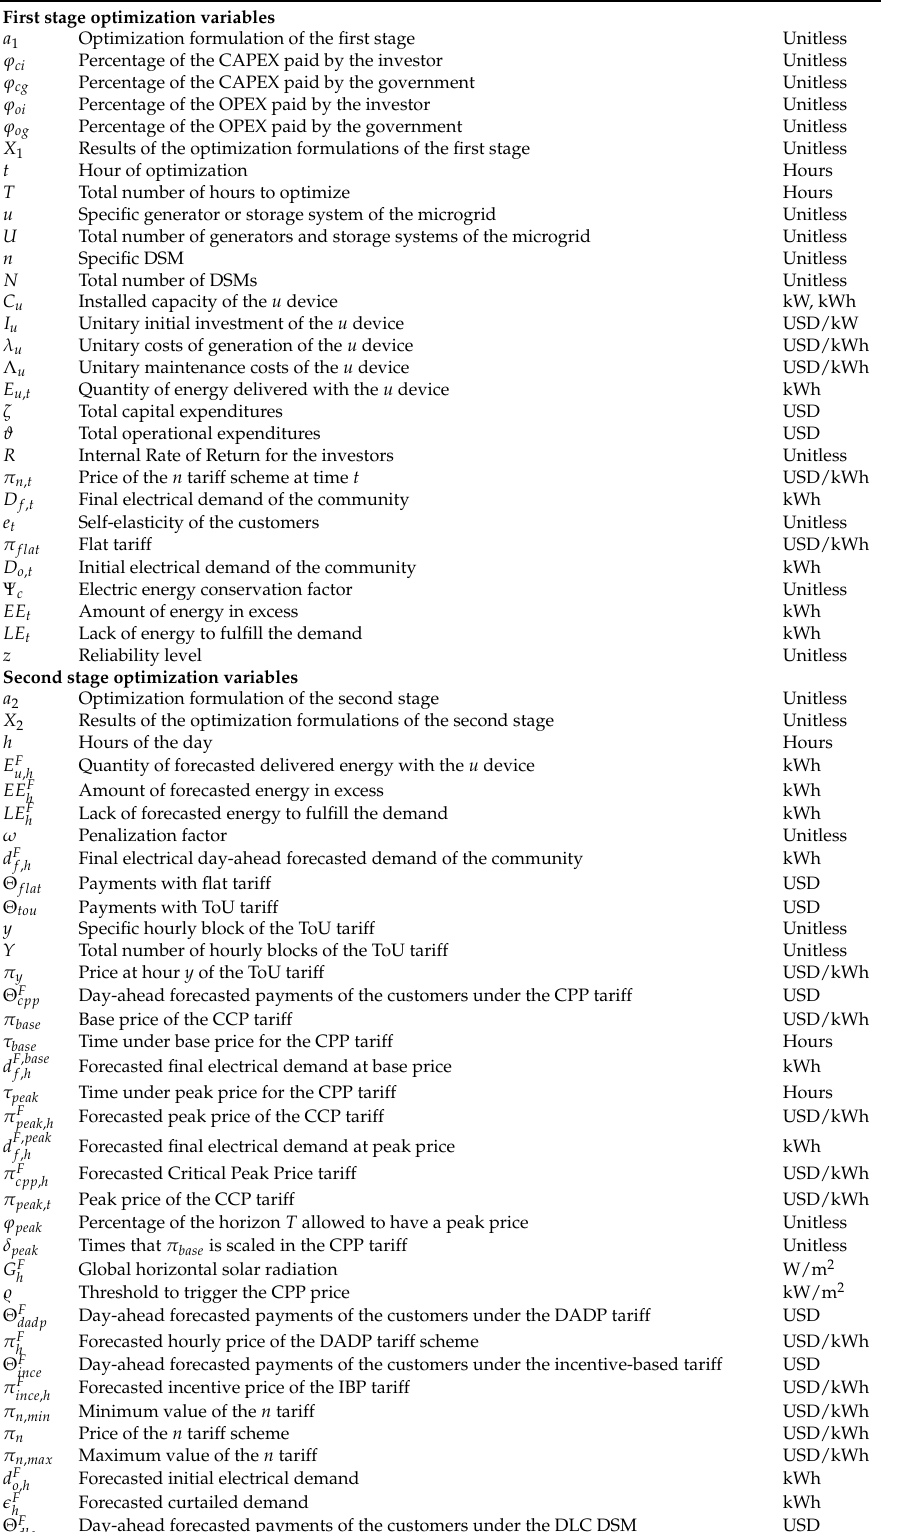
Table A1. Variable